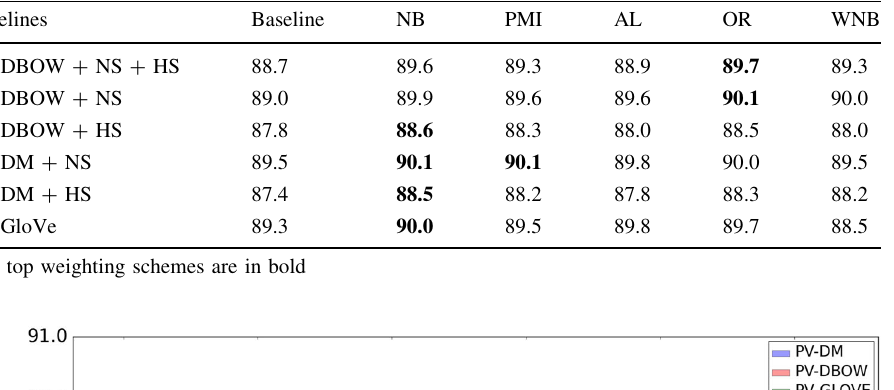
Fig. 4 Effectiveness of weighting schemes on PV and PV-GloVe. Negative sampling is selected as